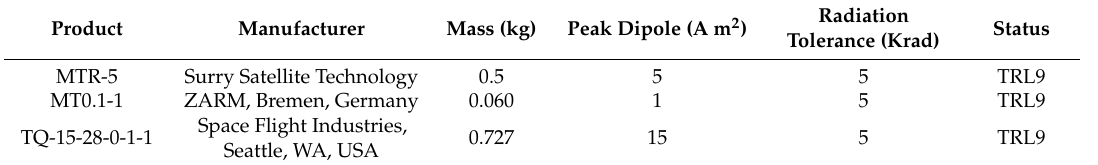
Figure 34. KySat-1 Altitude Control System (Space Challenges Program, 2013) [54]. Table 17. Magnetorquer Performance Data [23].